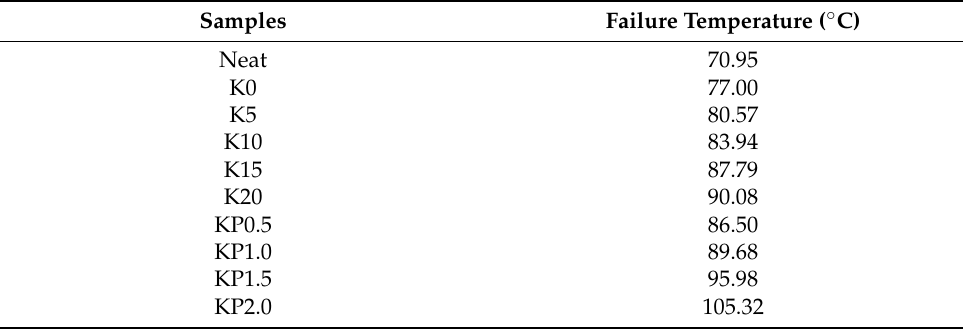
Figure 4. The fitting plots of G*/sin δ versus temperature for all samples: ( a ) SBS/OSDOA-modified asphalts; ( b ) composite modified asphalts. Table 7. Failure temperatures of all tested